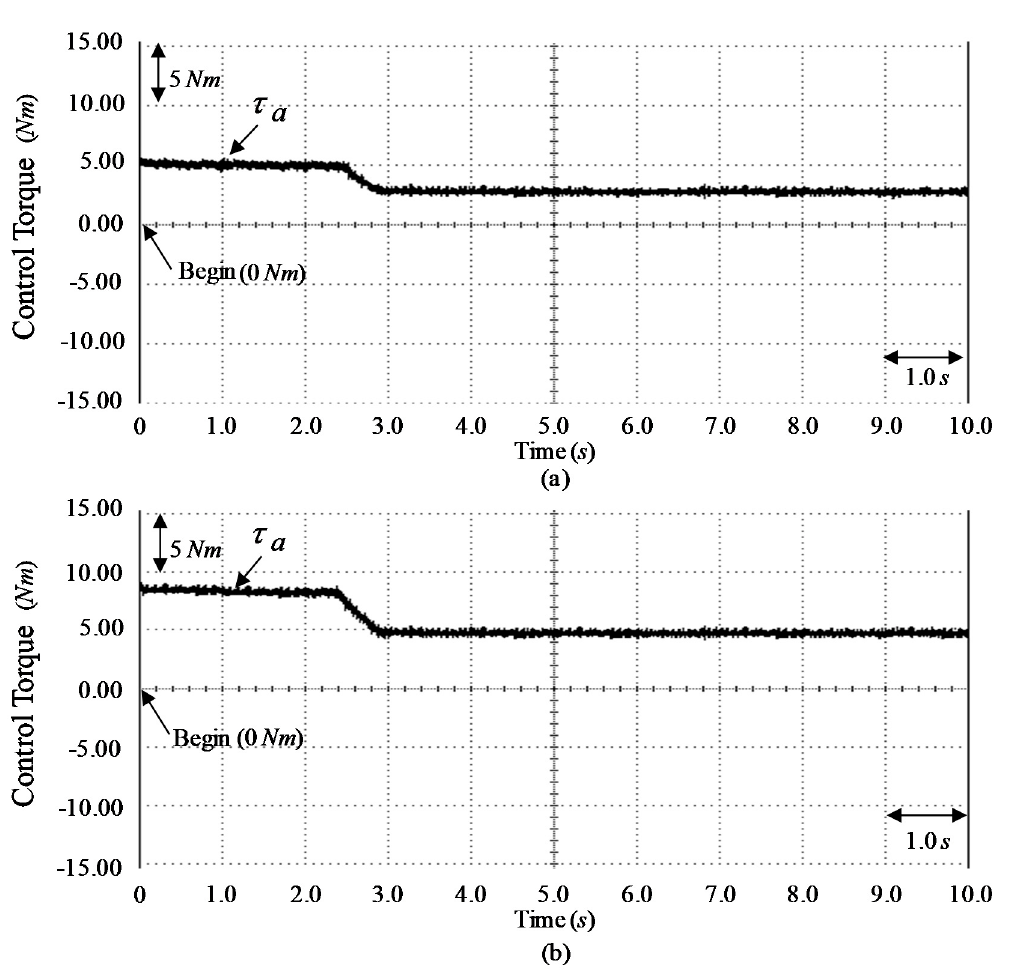
Figure 11. Tested results for the SIM expelling CVT organized system by using the controller CT2: ( a ) response of developed torque τ a at the tested Event E1 case, ( b ) response of developed torque τ a at the tested Event E2